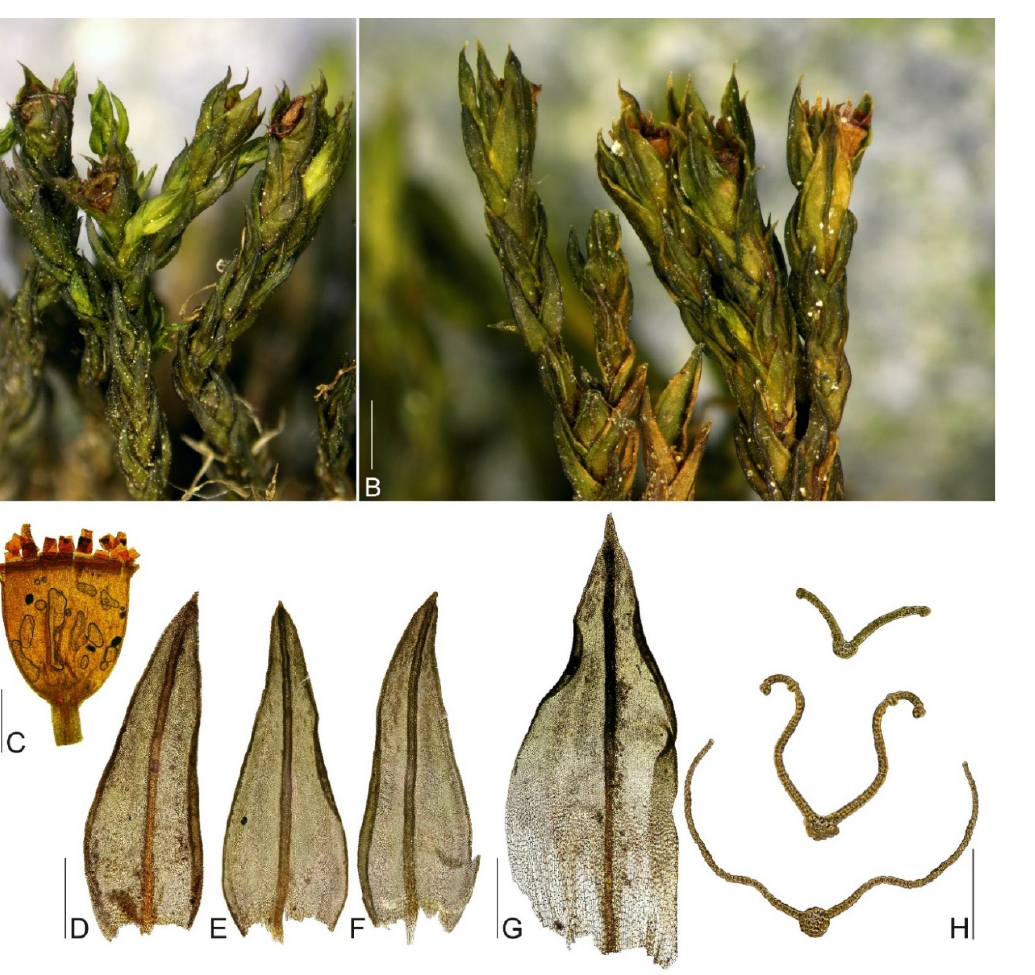
Figure 4. Macro and micro photographs of Schistidium sibiricum : ( A , B ) view on fertile plants; ( C )—capsule; ( D – F ) leaves; ( G ) perichaetial leaf; ( H ) leaf cross-sections (from the base of the leaf to the tip). Scale bars: ( A , B )—1 mm, (C – G )—0.5 mm, ( H )—0.1 mm. All photos from specimen OSTR #7253, made by V. Pl á